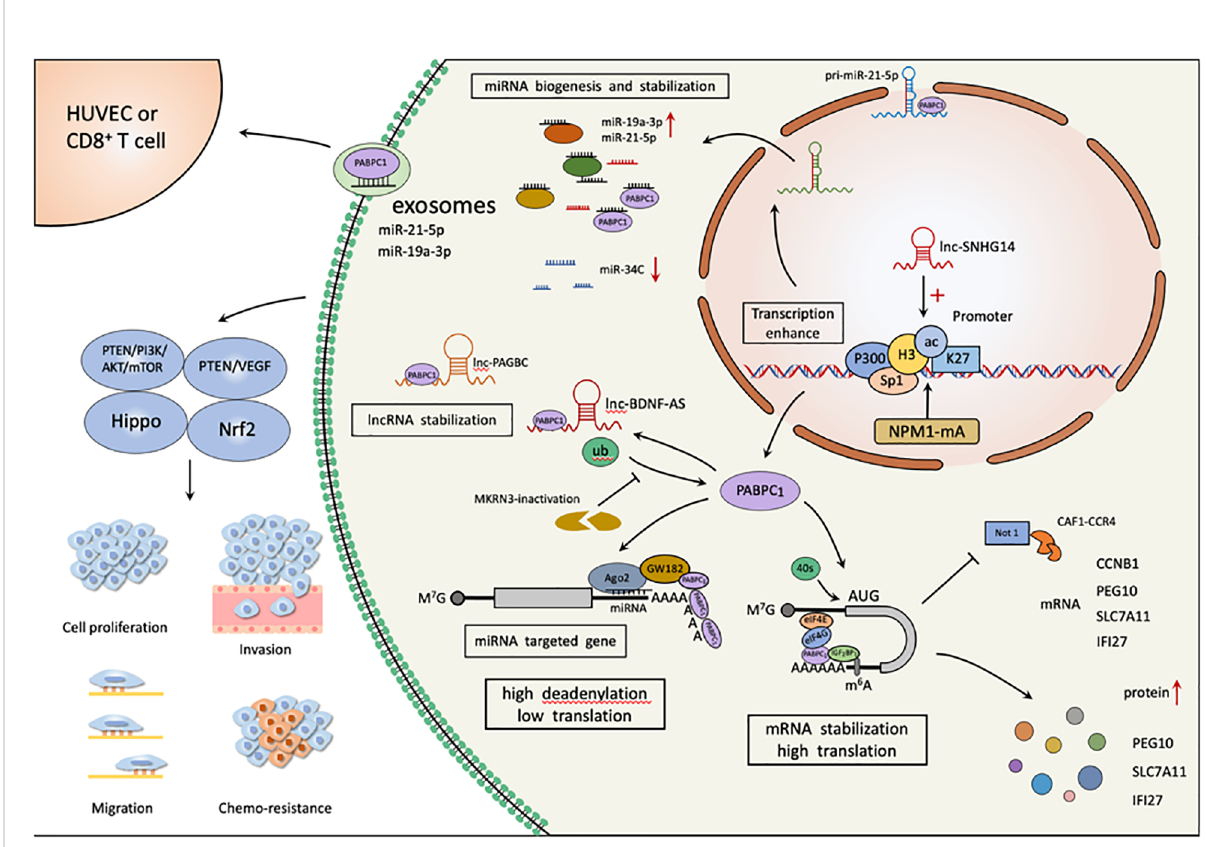
FIGURE 2 PABPC1 is involved in various aspects of tumor malignant biological behavior as an RNA binding protein. NPM1mA, SNHG14, Sp1 and p300 signi fi cantly induce upregulation of PABPC1 expression by increasing acetylation of PABPC1 promoter H3K27 and H2K37; Inactivated MKRN3 reduces PABPC1 ubiquitination, promotes its binding to 3 ’ poly(A) tails of mRNAs, and thereby accelerates global protein synthesis and promotes cancer proliferation and progression. PABPC1 regulates the generation and stability of tumor-associated RNAs, and the intracellular tumorigenic miR-19a-3p, miR-21-5p, lnc-BDNF-AS, and lnc-PAGBC levels are elevated, along with increased translation of CCNB1, PEG10, SLC7A11, and IFI27, and elevated protein levels. PABPC1 enhances miR-19a-3p, miR-21-5p loading in tumor cell-derived exosomes, target vascular endothelial cells to induce angiogenesis, and CD8+ T cells to impair the immune